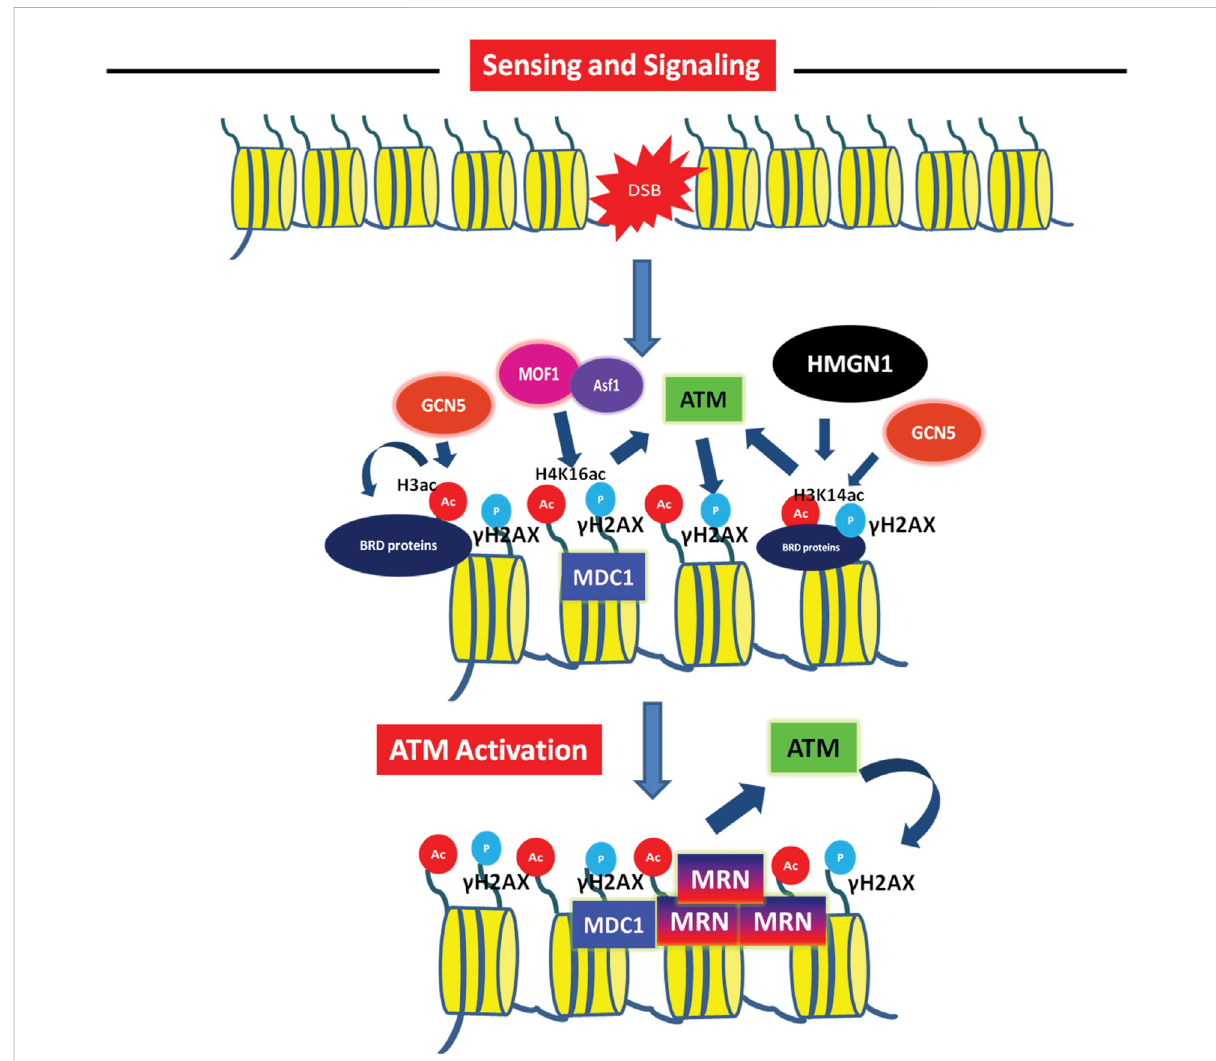
FIGURE 2 Role of acetylation in sensing and signalling of double-strand breaks Acetylation mediated activation of DNA damage checkpoint leading to DNA damage recognition- The checkpoint sensor ATM phosphorylates H2AX, leading to recruitment of MDC1. This MDC1 recruitment via interactionwith γ H2AXisfacilitatedbyH4K16acetylationmarkestablishedbyMOF1(withhelpofAsf1histonechaperon)attheDSB.TheH3K14acby GCN5 and docking of MDC1 promotes ATM activation and spreading of γ H2AX mark. This leads to recruitment of pathway speci fi c factors like the MRN